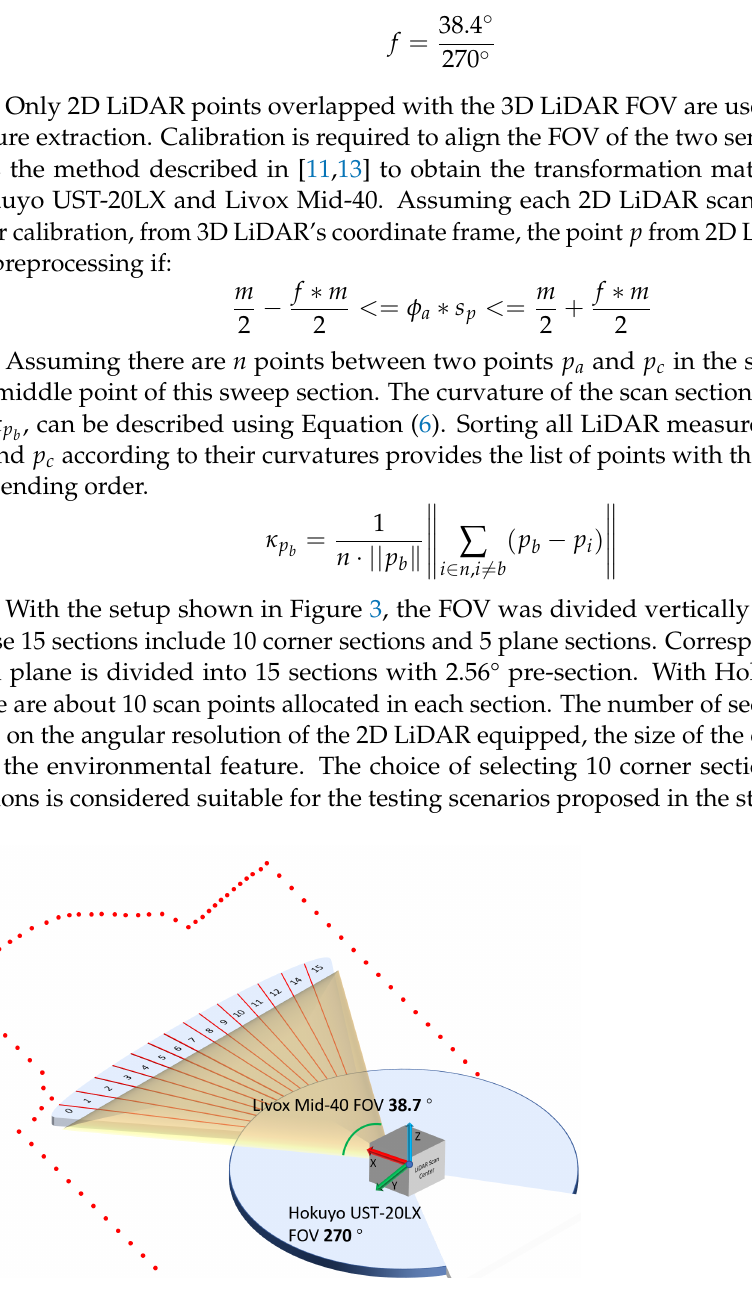
Figure 3. Overlapping FOV of the two